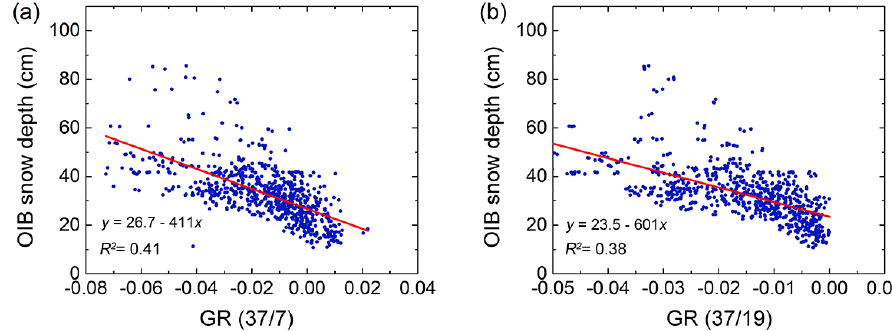
Figure 2. The scatter diagrams between the OIB snow depth and two GRs, i.e. GR(37 / 7) (a) and GR(37 / 19) (b) .